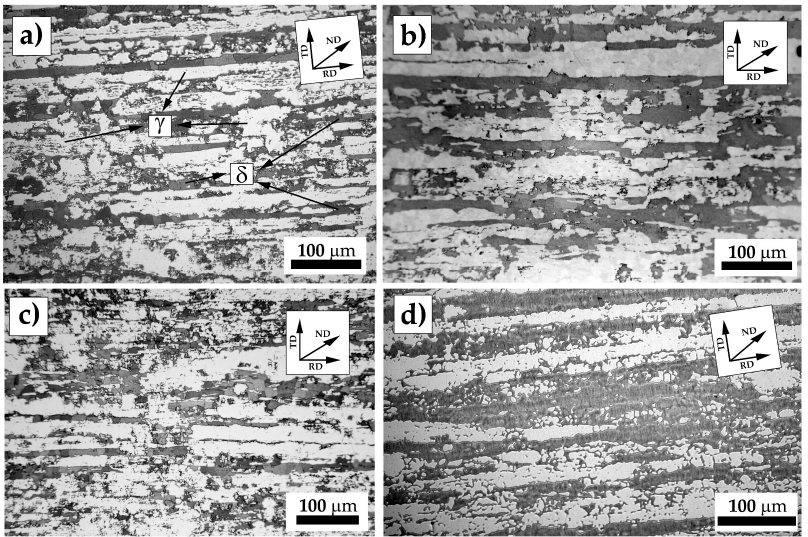
Figure 2. Microstructures of the as-received materials: ( a ) UNS S32101; ( b ) UNS S32205; ( c ) UNS S32304; and ( d ) UNS S32750. Etching solution was modified Beraha. RD, rolling direction; TD, transversal direction; ND, normal direction. Austenite and ferrite are depicted as γ and δ , respectively, in micrograph ( a